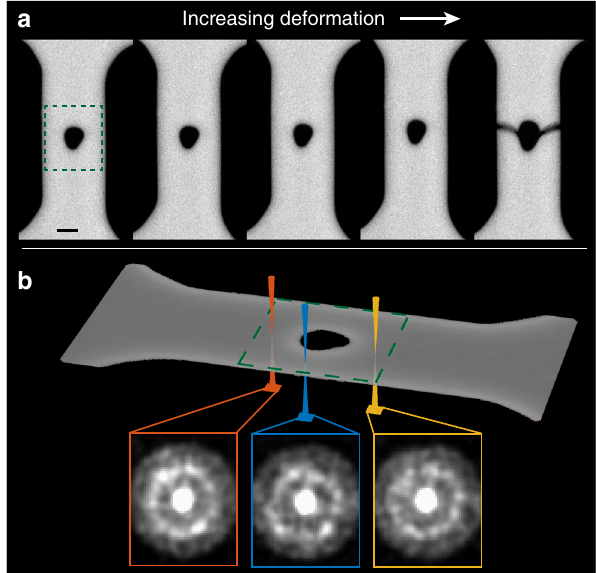
Fig. 1 A schematic overview of the experiment. a Annular dark fi eld (ADF) scans taken before, during, and after in situ deformation of a bulk metallic glass sample. The change in the size and shape of the hole is indicative of plastic deformation. The lack of contrast change across the specimen suggests constant sample thickness. The green dashed box shows where NBED was performed. The scale bar is 150 nm. b Schematic showing the NBED process in the metallic glass. As the beam rasters over the area, a full map consisting of over 33,000 nanobeam electron diffraction patterns is recorded. The three patterns shown are examples containing two-fold (orange), four-fold (blue), and zero (yellow) symmetries,